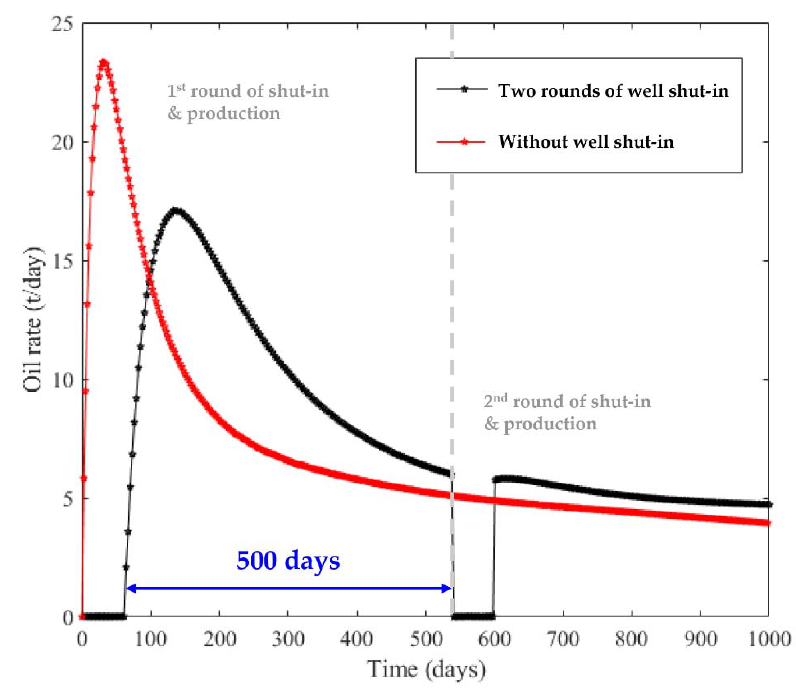
Figure 19. Daily oil rate with 500 days of first round of production.